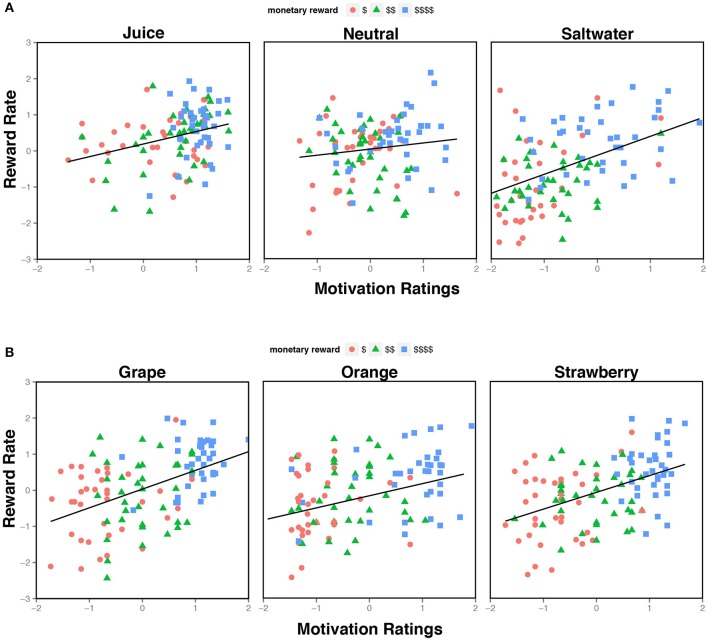
Relationship between Motivation Ratings and Reward Rate. (A) The scatterplot illustrates self-report motivation ratings from Experiment 1, divided by liquid feedback type, and expressed as normalized residuals (i.e., controlling for individual differences in mean rating). Each plot contains three measures (for low, medium, and high reward) for each subject. A wider spread of residuals was observed during the saltwater condition compared to the neutral and juice. (B) The scatterplot illustrates the normalized residuals of the motivation ratings from Experiment 2, separated by juice identity. Each plot contains three measures (for low, medium, and high reward) for each subject. Unlike the residuals in Experiment 1, there is not a clear difference in spread across the different liquid conditions.